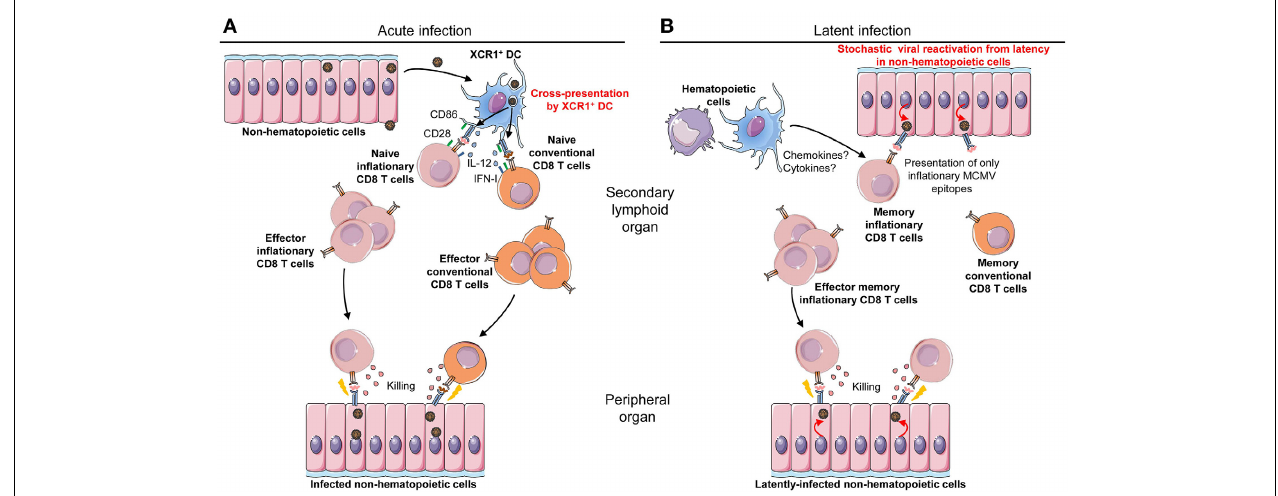
FIGURE 3 | Requirements for different antigen-presenting cell types during acute vs. latent MCMV infection. (A) Professional cross-presenting XCR1 + cDC are necessary and sufficient for priming of MCMV-specific CD8 T cell during acute infection. XCR1 + cDC are able to take up and process antigenic proteins derived from infected cells, either non-hematopoietic cells as illustrated or the small fraction of infected DC. Once they have processed viral proteins into epitopic peptides, XCR1 + cDC can present them in association with MHC-I molecules (signal 1) to anti-MCMV CD8 T cells. The priming of naïve CD8 T cells for the induction of protective antiviral responses also requires activating co-stimulation signals (signal 2), such as the engagement of CD28 on the lymphocytes by CD80/CD86 expressed by the DC, and activating cytokines (signal 3) such as IL-12 or IFN-I. XCR1 + cDC are also competent for delivery of signals 2 and 3. Upon priming, naïve conventional and inflationary CD8 T cells differentiate into effector conventional and inflationary CD8 T cells, respectively, which control acute